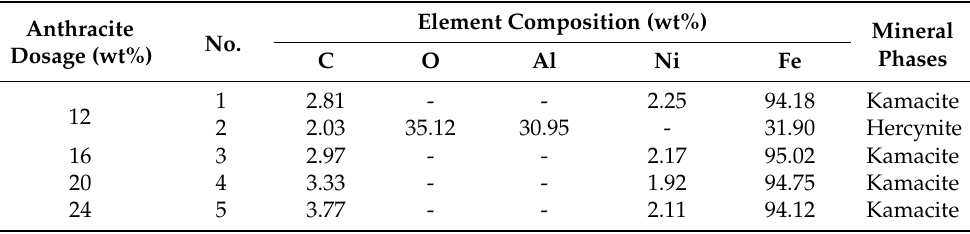
Table 4. EDS analysis results of co-reduction product for areas in Figure